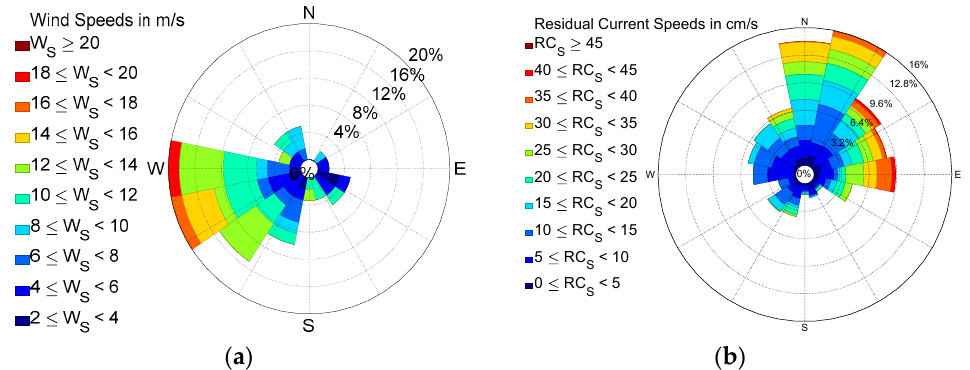
Figure 11. Rose diagram for winter. ( a ) wind; ( b ) residual currents.